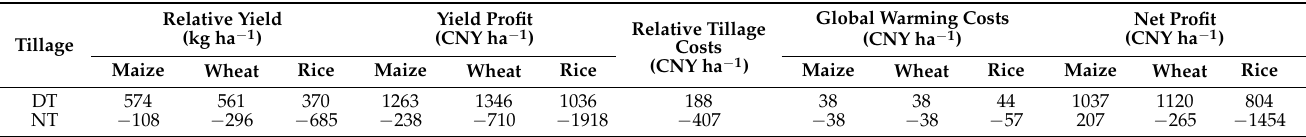
Table 3. Comparison of economic benefits for different cropping systems under DT and NT compared to RT management plans. The relative yield and tillage costs correspond to the yield and tillage costs of DT and NT compared to RT. CNY, Chinese yuan; DT, deep tillage; NT, no tillage; RT, rotary